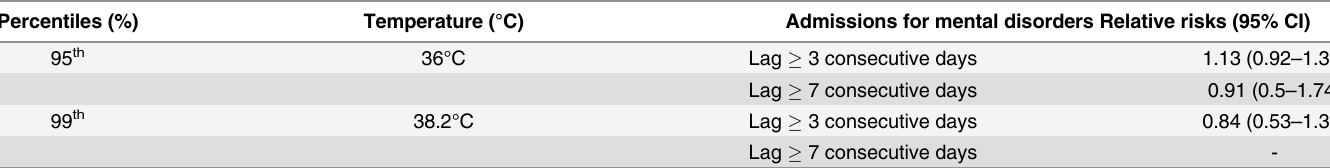
Table 4. Admissions for mental disorders by daily maximum temperature at lags at 95 th (36°C) and 99 th (38.2°C) percentiles of maximum temperature. Percentiles